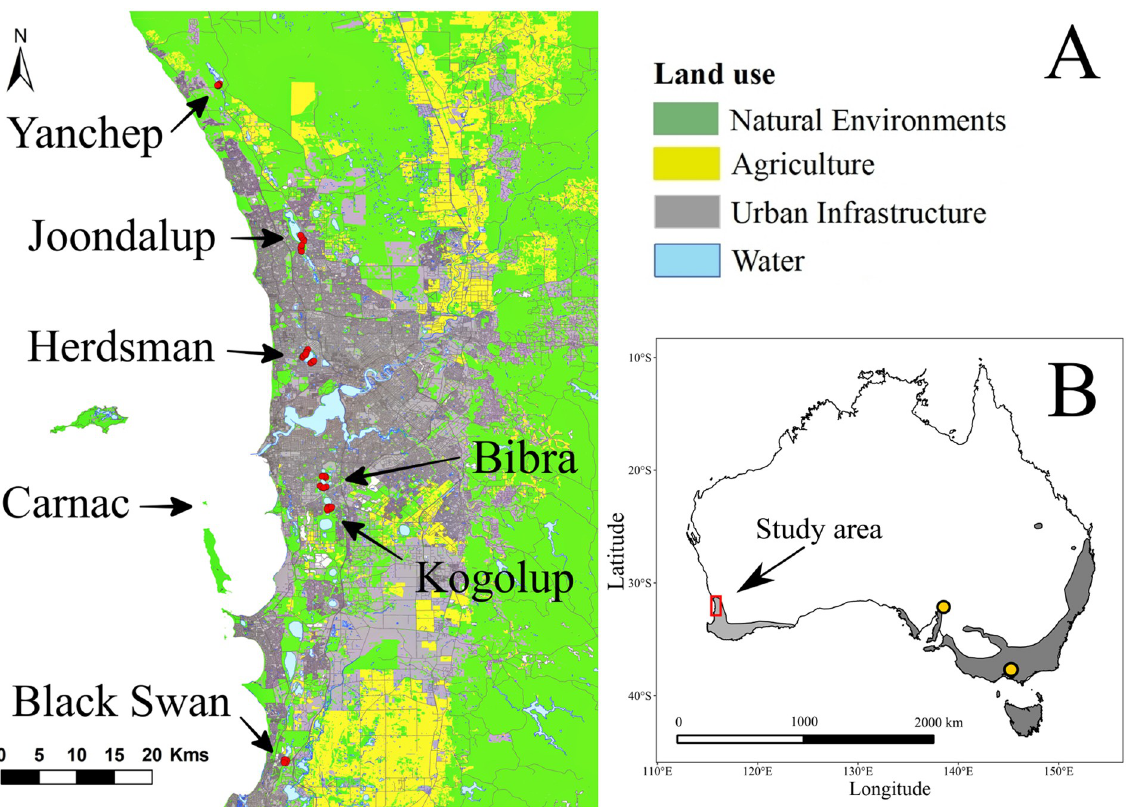
Fig 1. Map the studied populations of Notechis scutatus occidentalis and land-use of Perth, Western Australia. Red points represent individual Western tiger snakes, and yellow points represent Eastern tiger snakes ( Notechis scutatus scutatus ). Grey shading represents the current distribution extent of the species (light = Western, dark = Eastern; modified from the IUCN Red List of Threatened Species [37]). Land- use was classified by the 2016 Australian Land Use and Management Classification (Australian Bureau of Agricultural and Resource Economics and Sciences, Canberra. CC BY